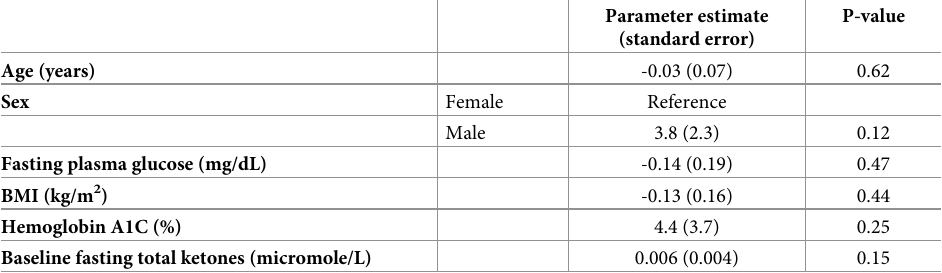
Table 3. Multivariate regression of change in minimal model insulin